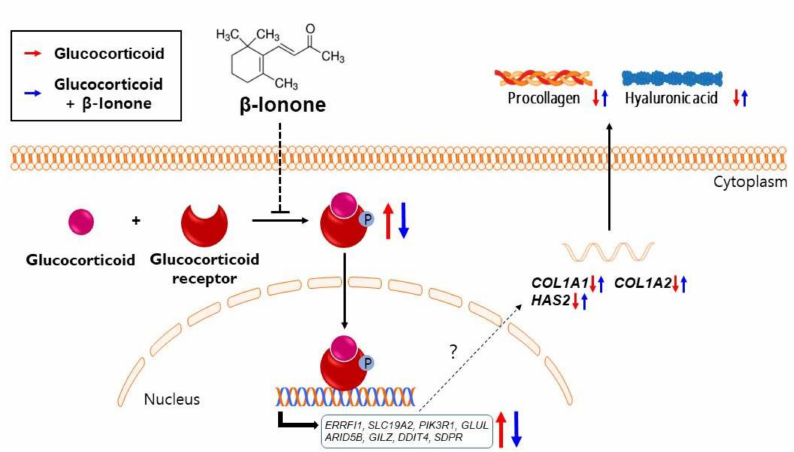
Figure 7. A suggested mechanism by which β -ionone attenuates glucocorticoid-induced suppression of collagen and hyaluronic acid synthesis in human dermal fibroblasts. As shown in a schematic illustration, the inhibition of glucocorticoid binding to its receptor by β -ionone suppresses the glucocorticoid-induced GR signaling and subsequent collagen and hyaluronic acid degradation. The detailed molecular mechanism of how GR transcription factor regulates collagen and hyaluronic acid needs further